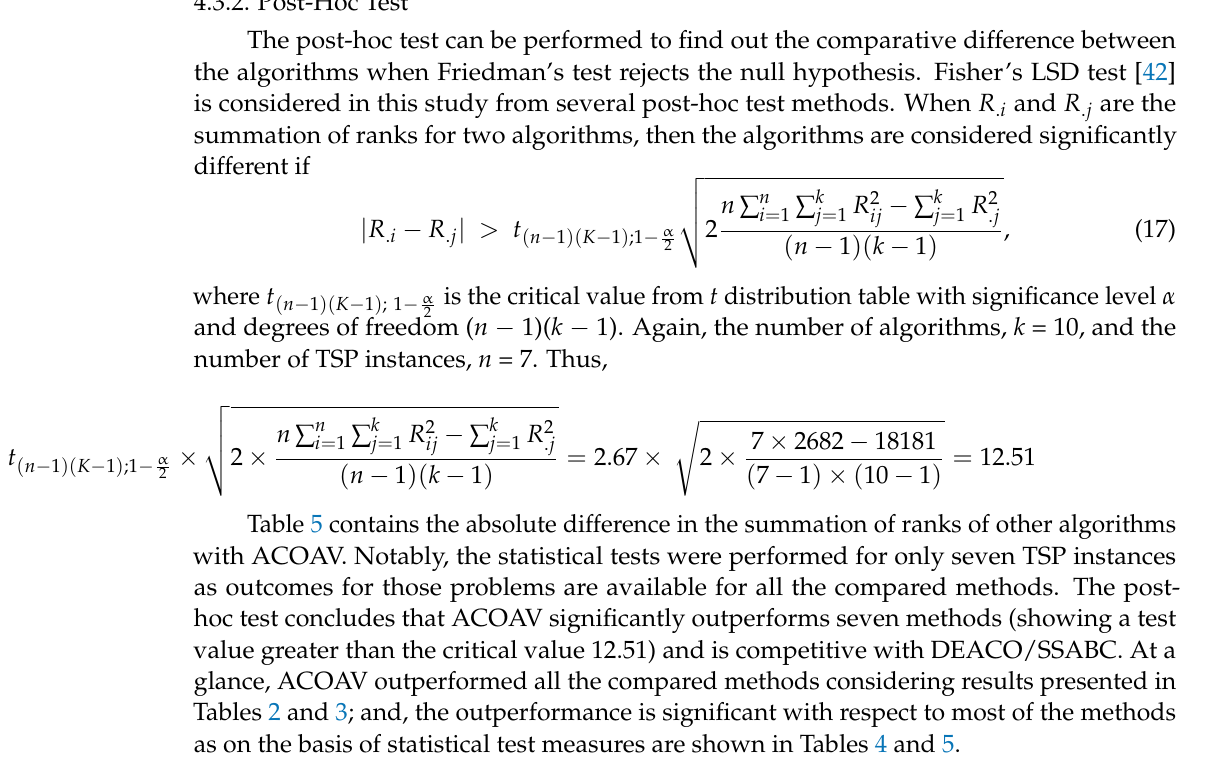
Table 5. Post-hoc Test of proposed ACOAV with Existing State-of-the-Art Bio-inspired